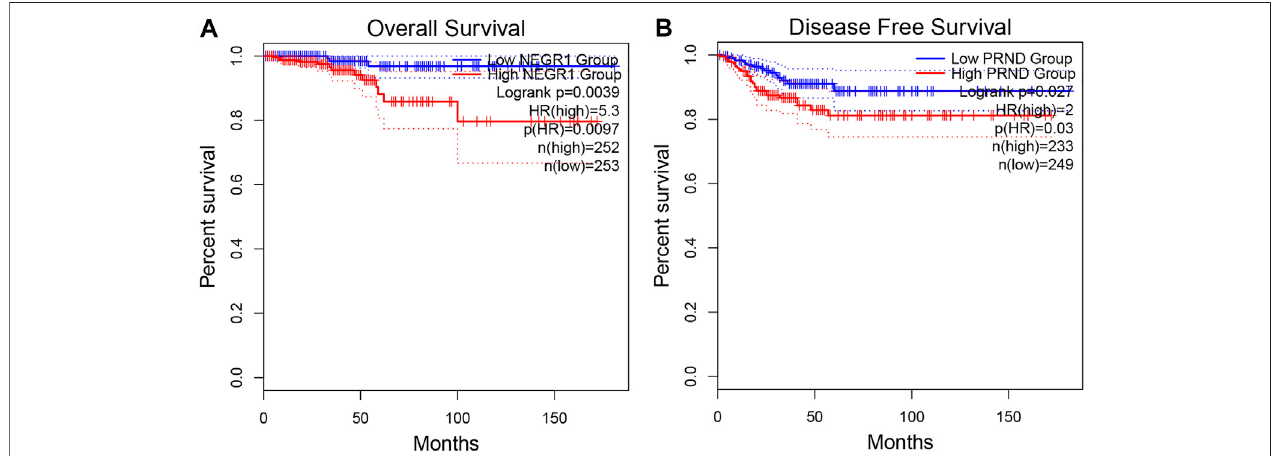
FIGURE 6 | Overall survival analysis of NEGR1 (A) and disease free survival analysis of PRND (B) based on GEPIA2.